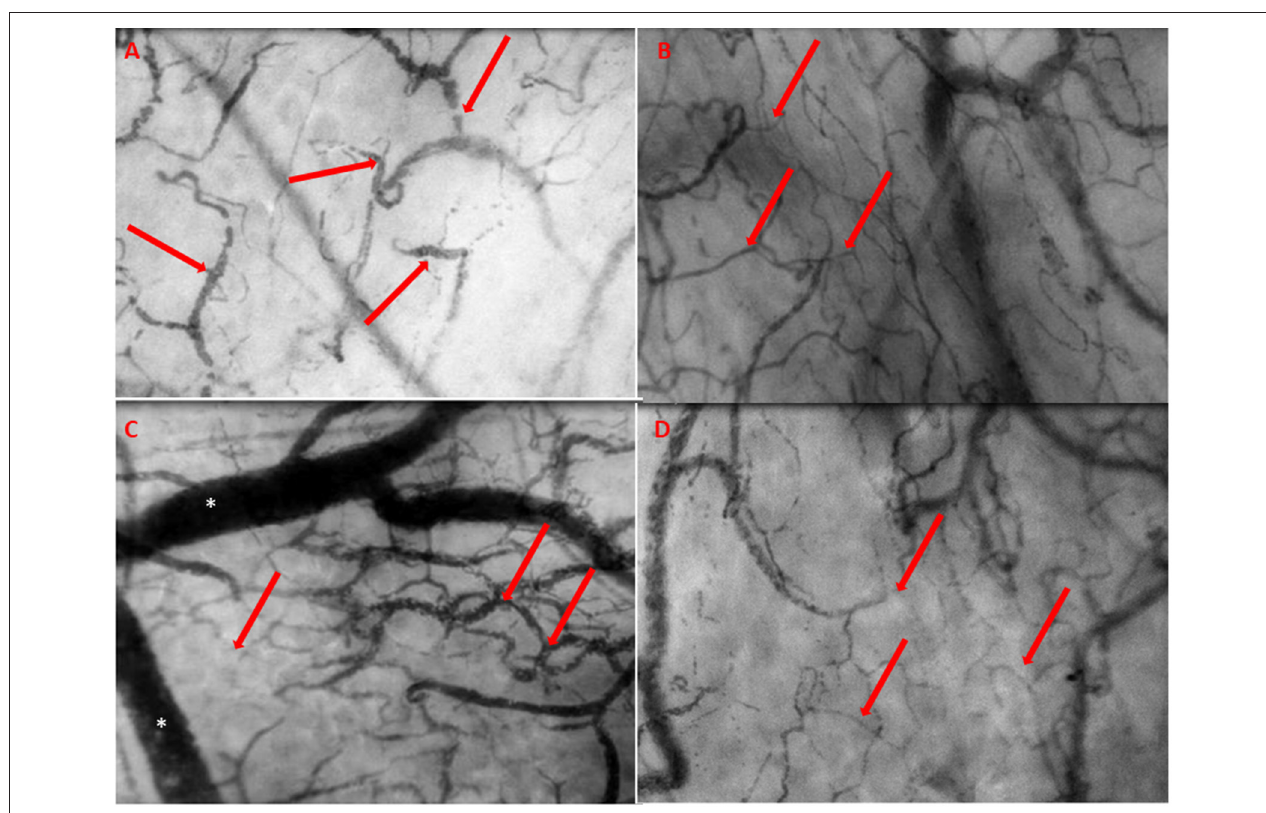
FIGURE 1 | (A) The day prior to LVAD implantation. The microcirculation is typical as seen in heart failure characterized by slow, sludging flow (red arrows), stasis of red blood cells, and low capillary density. (B) The day after LVAD implantation with improved microcirculatory flow with a high red blood cell (RBC) velocity, concordant blood flow in all quadrants, and increased capillary density (red arrows). (C) The day of event, 10 days post-surgery, showing severe deterioration of microcirculation with severe stasis of red blood cells (red arrows) and severe congestion and distention of the venules (*). (D) Prior to discharge , quietly normalized microcirculatory flow (red arrows) after revealing cardiac